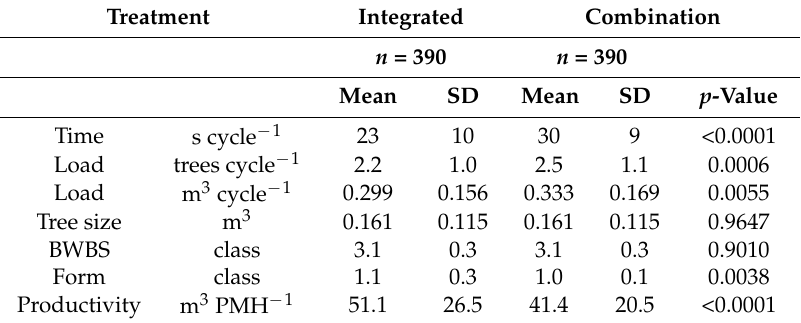
Table 5. Study results extracted from the balanced subset obtained from resampling.